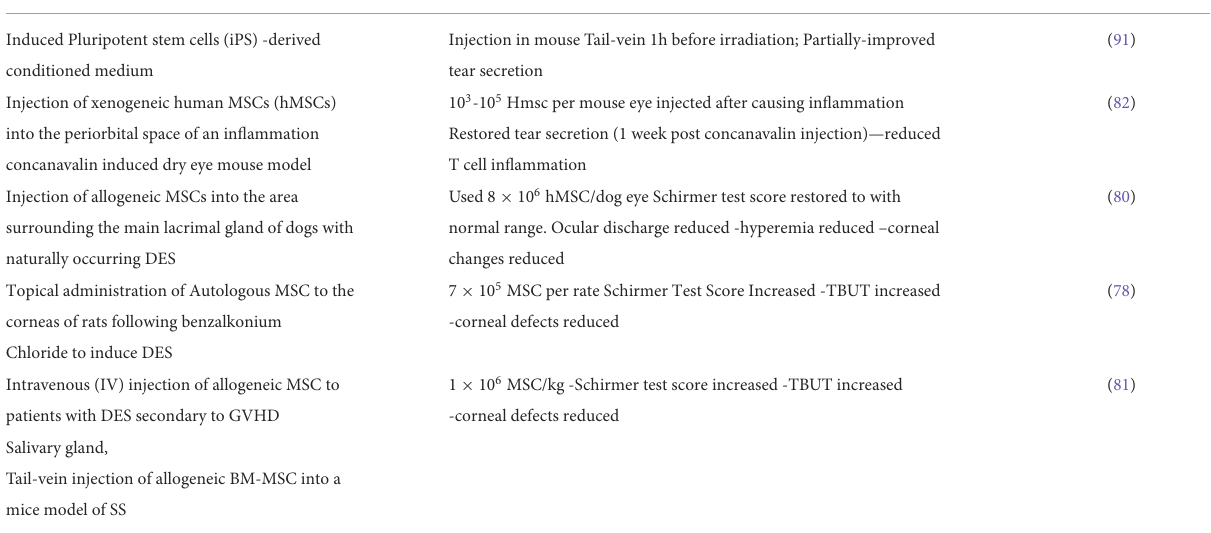
TABLE 3 Cell-based therapies for lacrimal gland